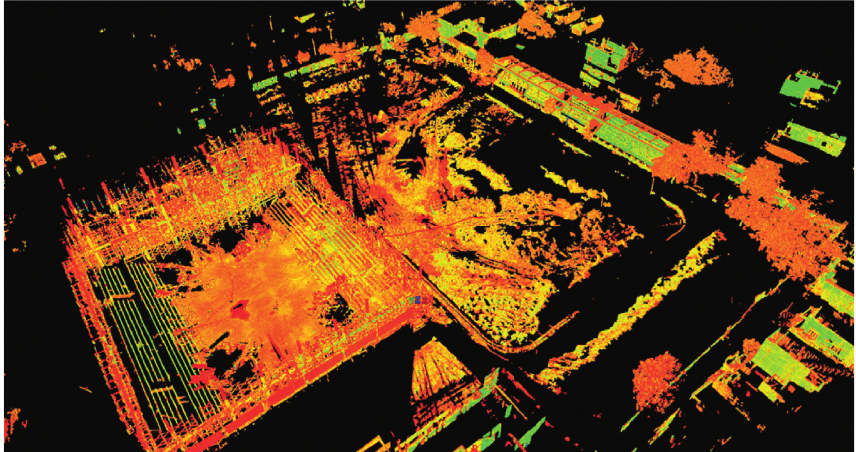
Figure 4: The collected point cloud.